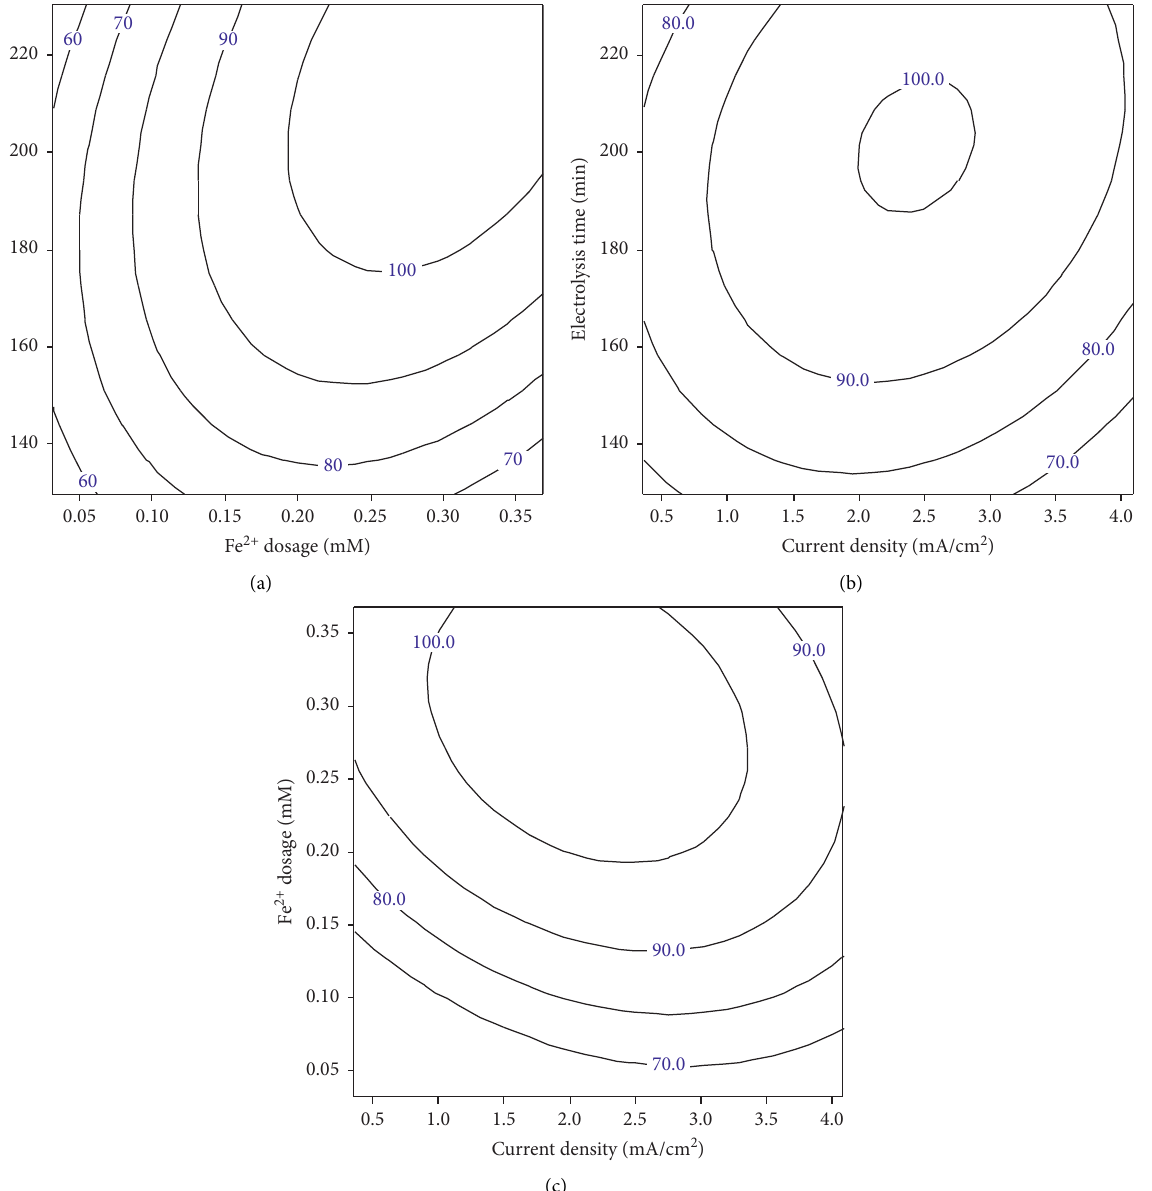
Figure 4: Respond contour plot of TC removal at fixed condition: (a) current density of 2.5 mA/cm 2 , (b) Fe 2+ dosage of 0.2 mM, and (c) electrolysis time of 200